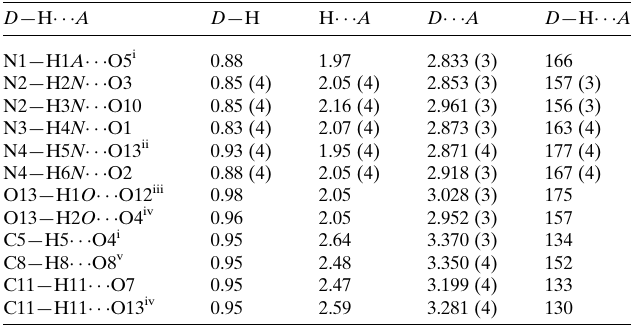
Table 4 Hydrogen-bond geometry (A˚ , (cid:3) ) for